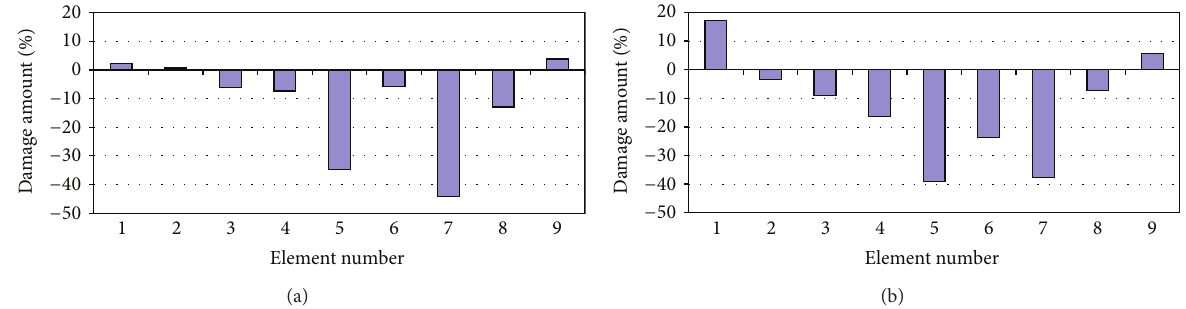
Figure 10: Inverse damage predictions for 𝐹 3 = 30 kN, (a) 5 experimental frequencies for damaged structure used, and (b) 8 experimental frequencies for damaged structure